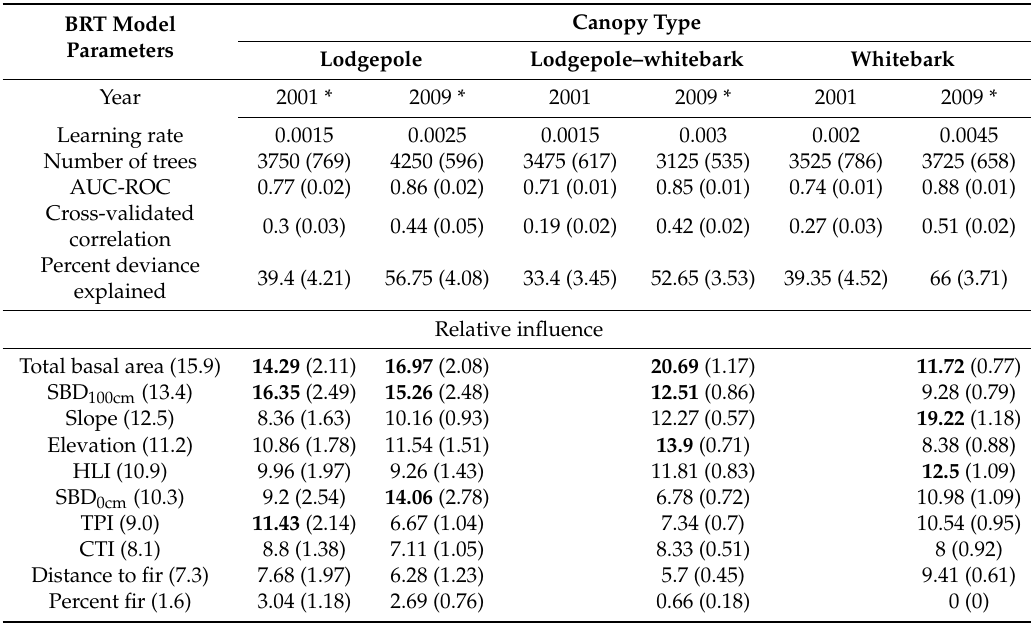
Table 2. Boosted regression tree model performance statistics and variable relative influence relating occurrence of multi-cell refugia to landscape